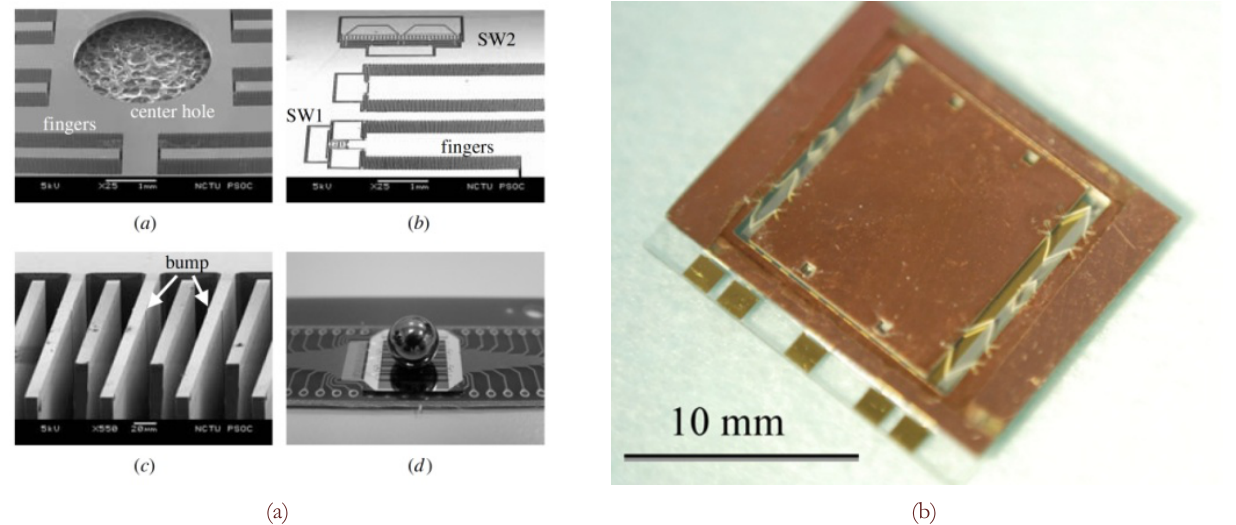
Figure 3: (a) Capacitive generator [12] including the seismic mass represented by a tungsten ball (4mm diameter) for the frequency tuning at 120Hz (31 μ W output power at 0.23g). (b) Capacitive generator with electret [13] (1 μ W output power at 63Hz and